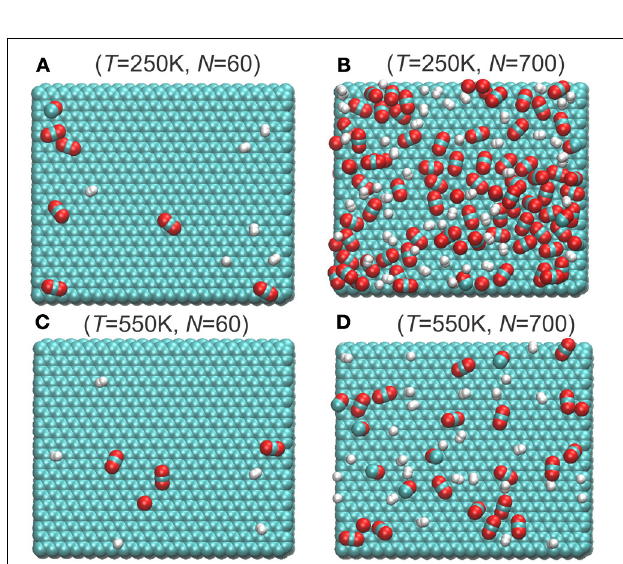
FIGURE 3 | Typical snaphosts of top view of molecules adsorbed on the graphite surface at different temperatures and total number of particles (A) T = 250K, N = 60; (B) T = 250K, N = 700; (C) T = 550K, N = 60; (D) T = 550K, N = 700, cf. Figure 6. Only the adsorbed layers below the dividing surface are shown (cf. Equation 14). The green, red, white represent carbon, oxygen, and hydrogen atoms, respectively.